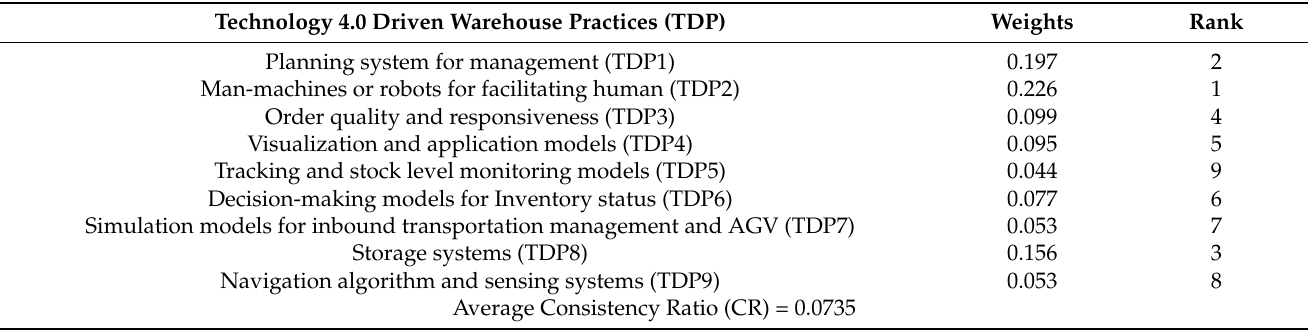
Table 7. Weight and rank Technology 4.0 driven warehouse